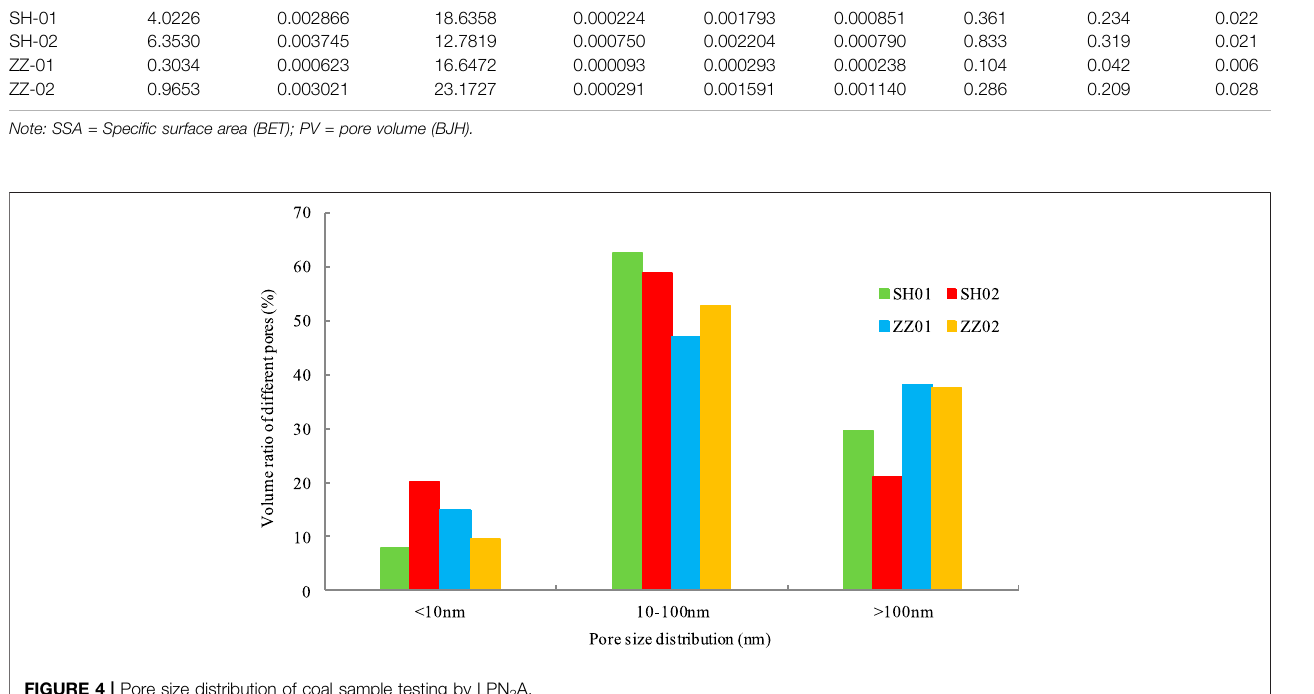
Frontiers in Earth Science |